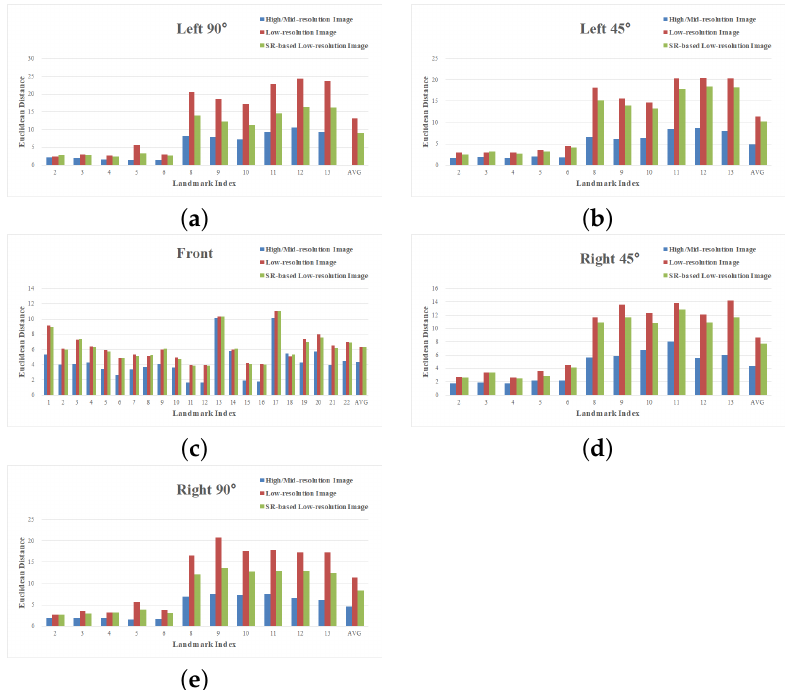
Figure 8. The comparison of average ED of same identity between high/mid-resolution, low- resolution, and enhanced low-resolution based on super-resolution method: ( a ) Left 90 ◦ ; ( b ) Left 45 ◦ ; ( c ) Front; ( d ) Right 45 ◦ ; ( e ) Right 90 ◦